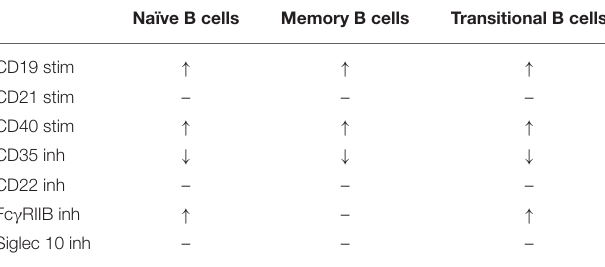
TABLE 1 | Aberrations in the expression of stimulatory (stim) and inhibitory (inh) receptors on the surface membrane of B cell subsets from patients with SSc. Naïve B